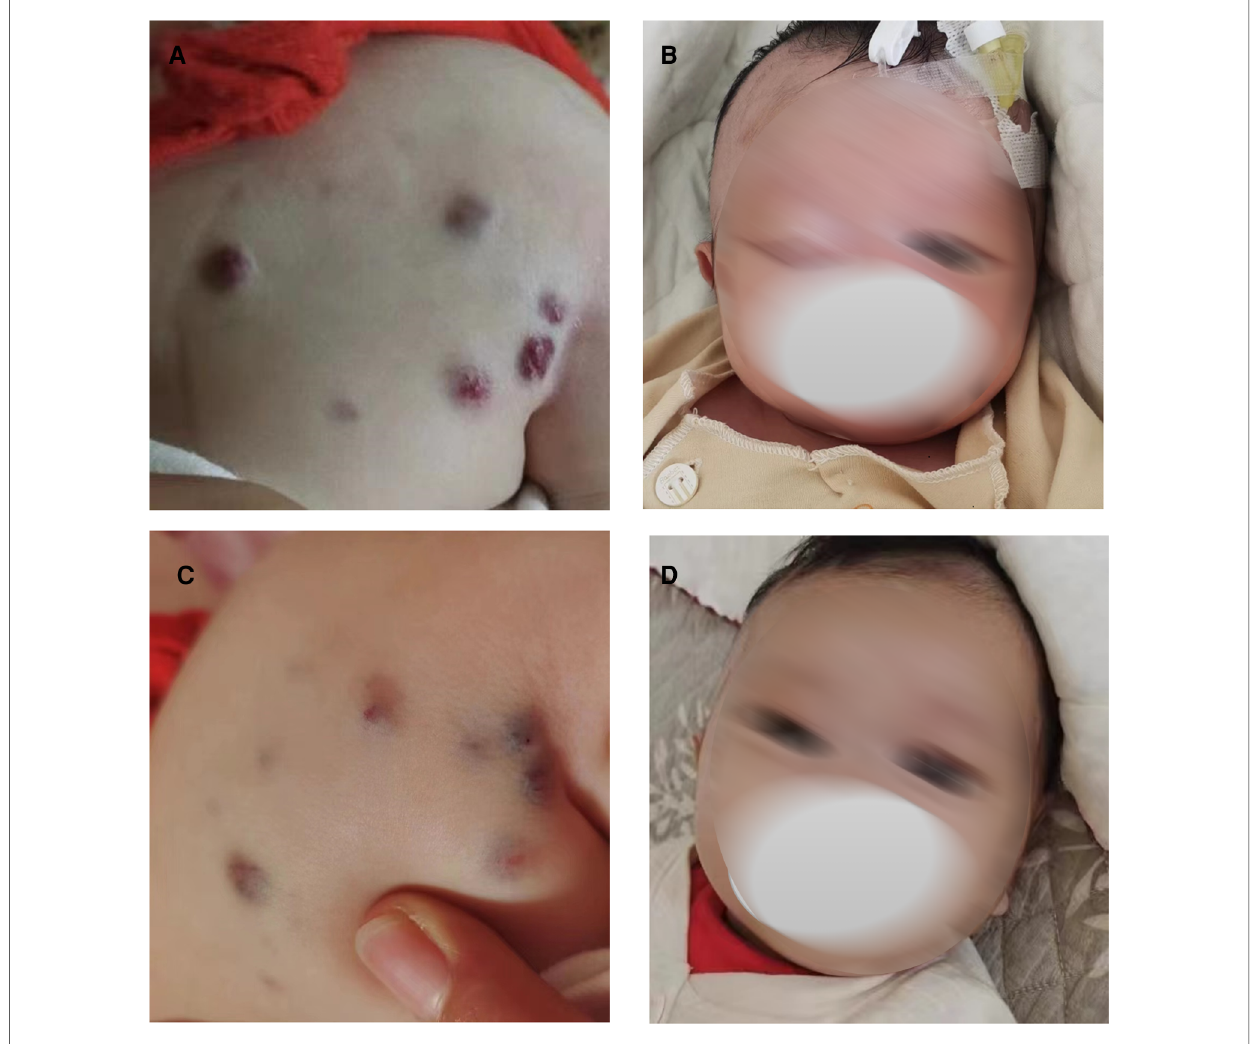
FIGURE 1 Blue rubber bleb on the back and eyes before and after low-dose sirolimus combined with glucocorticoids treatment. Blue rubber bleb on the back before treatment ( A ) and after treatment. ( C ) Blue rubber bleb on the eyes before treatment ( B ) and after treatment ( D